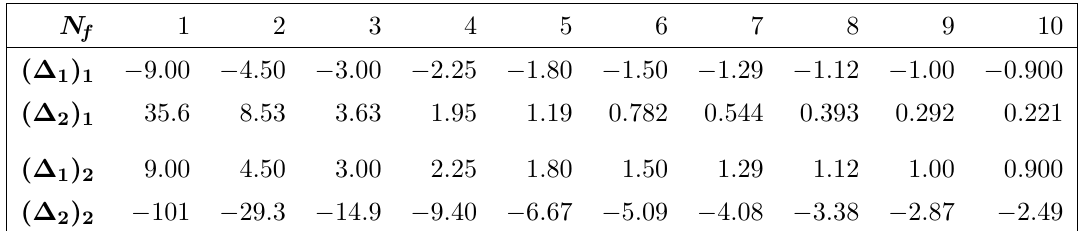
Table 5 . Three signi(cid:12)cant digits of the one-loop, ((cid:1) 1 ) i , and the two-loop, ((cid:1) 2 ) i , contributions to the scaling dimension of the (cid:13)avor-nonsinglet four-fermion operators for various cases of N f . To obtain the two-loop ((cid:1) 2 ) i values we implemented the algorithm to include the e(cid:11)ect of evanescent operators [32]. N f